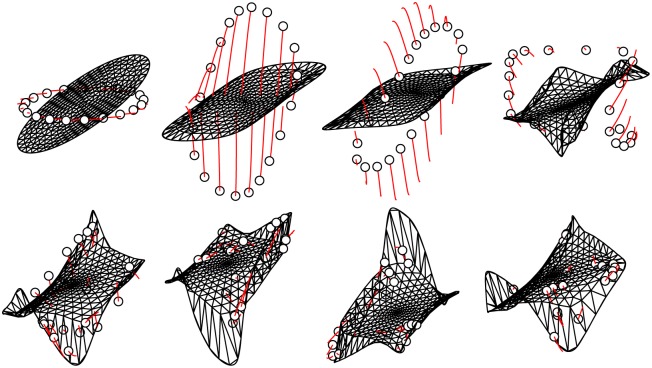
The (y1, y2, y42) projection of the AM and BM at times tω/(2π) = {0.005, 0.1, 0.15, 0.3, 0.6, 1.5, 2.0, 4.66} during a simulation.Overlaid are twenty different time series with tails tracing their motion shown in red. Each tail represents Δtω/(2π) = 0.05. The time series rapidly converge onto the manifold. The BM will expand to contain those attractors whose basins of attraction it intersects. The interior points are connected with truss elements of zero initial length which are shown in the figure.